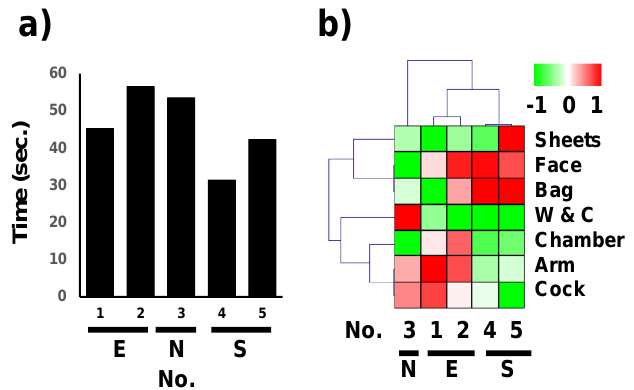
Figure 5. Durations corresponding to AOIs: ( a ) Total gaze duration of all AOIs throughout the task. ( b ) Clustering of gaze durations corresponding to different AOIs. For each participant, the gaze duration time was normalized to calculate the Z-score, and clustering was performed using Spearman rank correlation. The color bar on the right indicates the Z-score—red, green, and white denote relatively longer, shorter, and average durations, respectively. E, N, and S denote experienced, novice, and student nurses, respectively. W & C denotes watch and chamber, respectively.